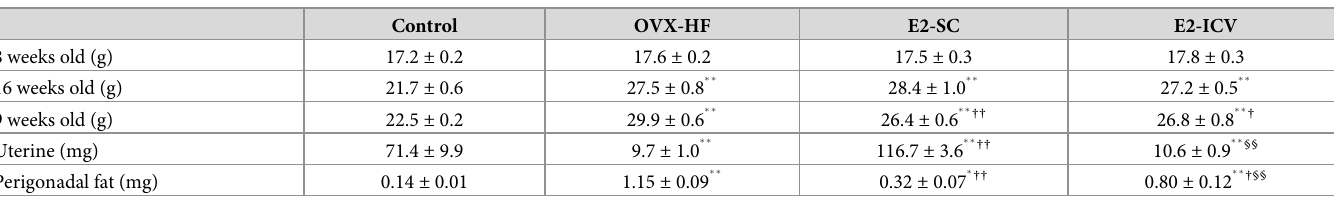
Table 1. Body weight and tissue weights of the